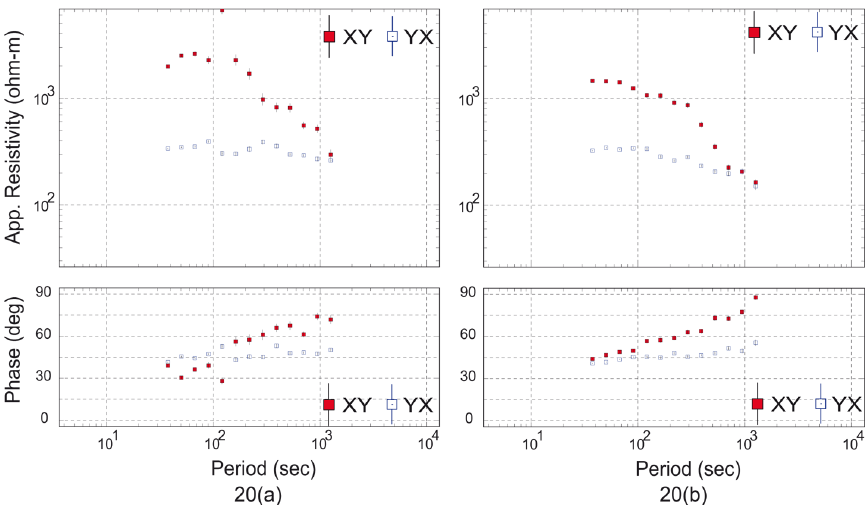
Figure 20. Interrelation between FFT length and Parzen radius for a small data set of 8S of site K11 with 38,628 data points. (a) Apparent resistivity (top panel) and phase (bottom panel) curves obtained from the data using a FFT length of 2048 and a Parzen radius of 0.13 (b) Apparent resistivity (upper panel) and phase (lower panel) curves obtained using a FFT length of 512 and a Parzen radius of 0.7 from the same data. Regarding small data set a small FFT length and a big Parzen radius provide an acceptable outcome. The red colored boxes rep- resent XY components and the blue colored boxes represent YX components of apparent resistivity and